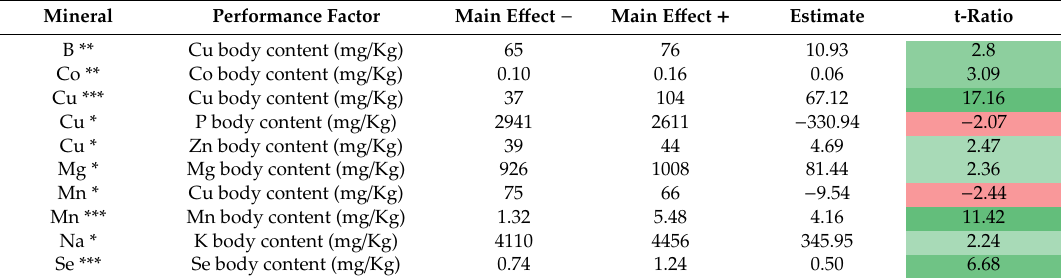
Table 7. E ff ect of significant mineral inclusions on mineral content of prawn body sampled at Day 42 using two-level screening analysis. p -values are denoted by an asterisk (* p < 0.05, ** p < 0.01, *** p < 0.001). t-ratios of minerals highlighted green have a positive e ff ect and red have a negative e ff ect on the performance parameter where the shading reflects the magnitude (i.e., darker shading has a higher magnitude of e ff ect and vice